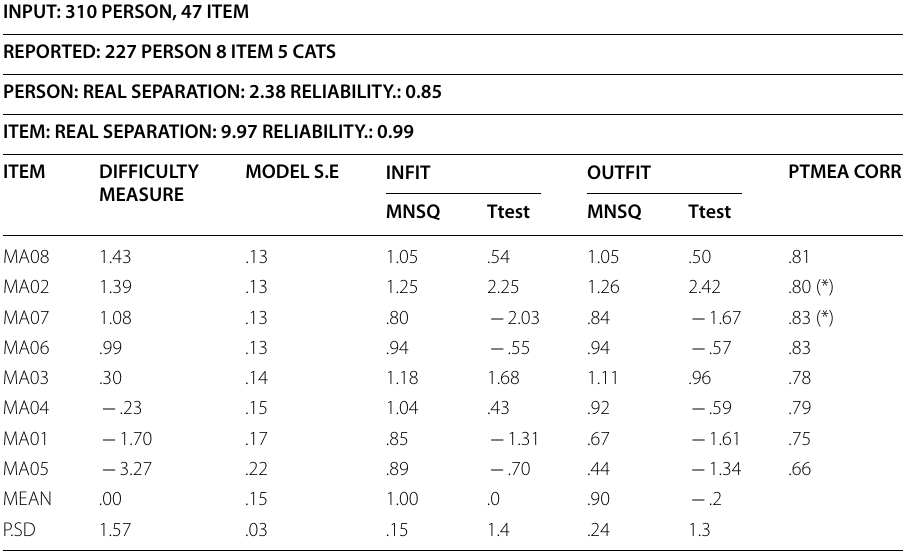
Table 6 Dimension MA: Item difficulties, standard errors, Infit, Outfit, T-test and correlations, estimated from final